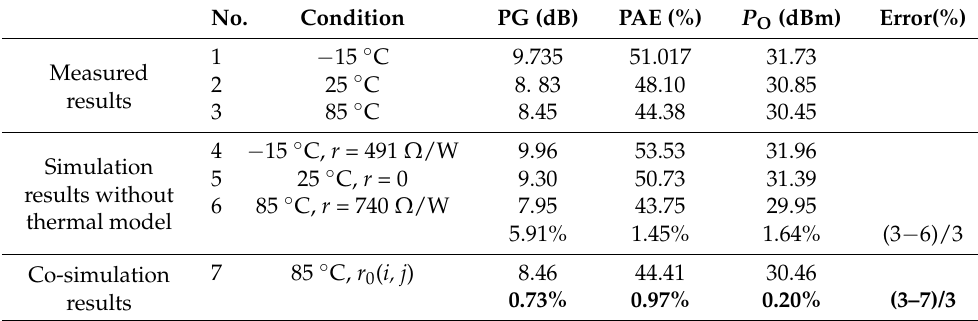
Figure 11. Temperature distribution and thermal resistances of amplifier cells. Table 3. Comparison of the measured results and simulated results.